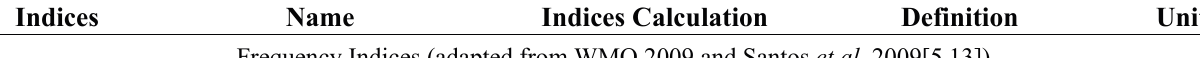
Table 1. Definition of